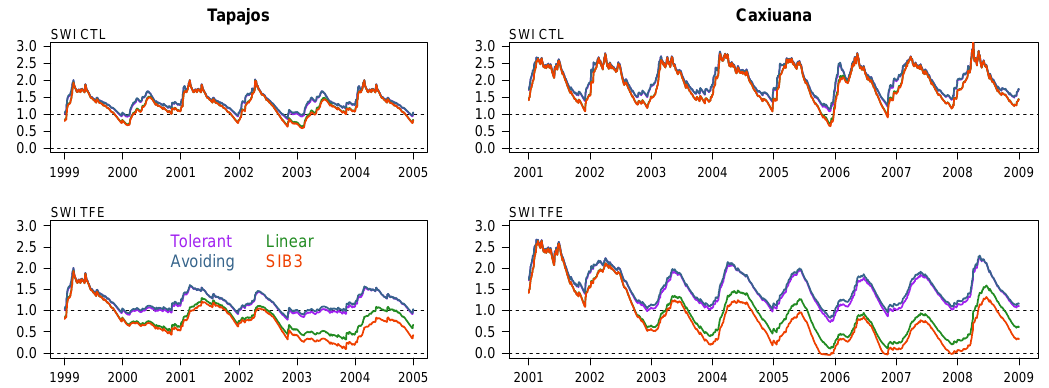
Figure 4. Simulated daily soil wetness index (SWI) with the four water stress function (WSF) at Tapajós (left) and Caxiuanã (right) for both Figure 4 – Simulated daily Soil Wetness Index (SWI) with the 4 WSF at Tapaj´os (left) and Caxiuan˜a (right) for both CTL control (CTL) (top) and throughfall exclusion (TFE) for the full experimental (top) and TFE for the full experimental period.